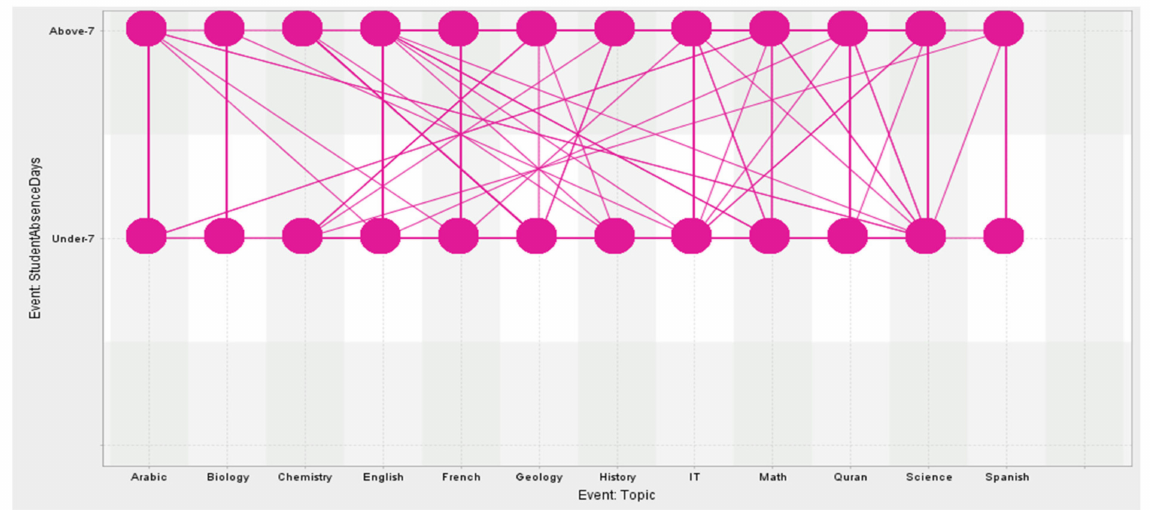
Figure 10. Visualization of the interconnection between a topic and the number of days the students were